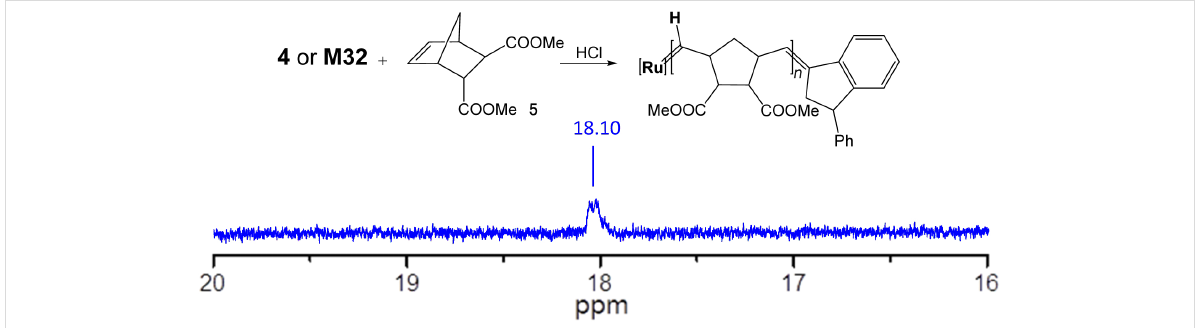
Figure 3: 1 H NMR spectrum in the low-field region of the active species for complexes 4 and M32 .